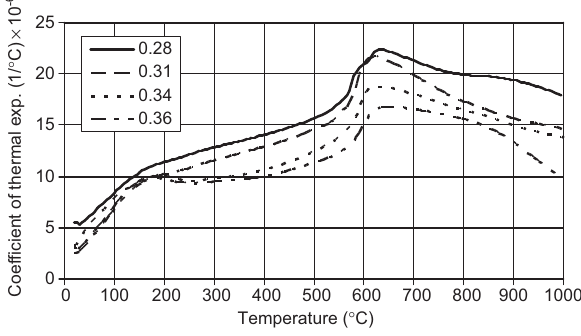
Figure 9 The first derivation of thermal strain curve of SCLC with tuff.